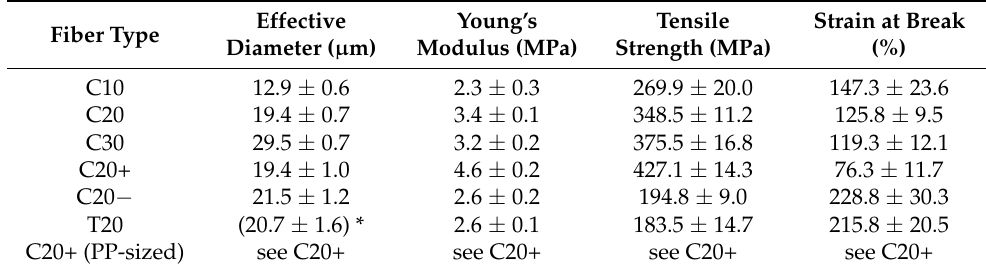
Figure 3. Tensile stress–strain curves of all polypropylene fibers under investigation (C—circular, T—trilobal; 10/20/30 diameter in µ m, +/ − in − /decreased stretching during production). Table 3. Geometric and mechanical properties of the polypropylene (PP) fibers produced, clamping length 10 mm, strain rate 0.5 min − 1 , * equivalent